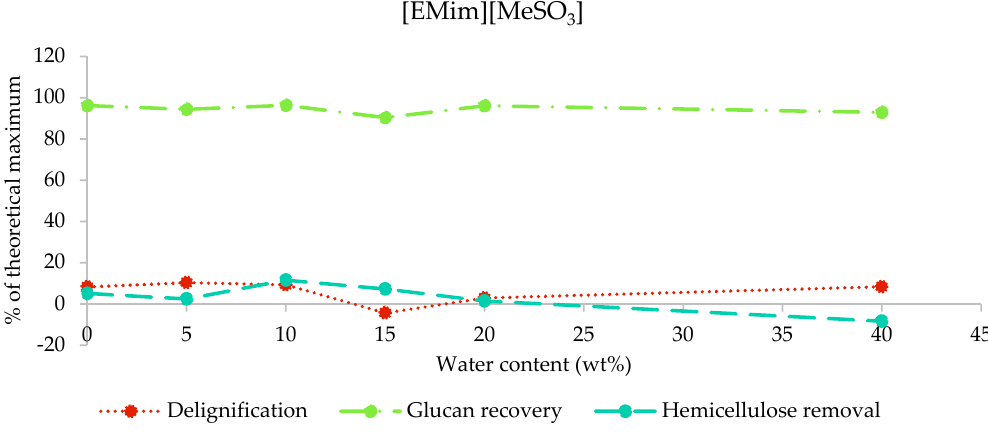
Figure 4. Delignification, glucan recovery, and hemicellulose removal after the pretreatment of poplar with [EMim][MeSO 3 ] containing 0–40 wt% water for 46 h at 100 °C.